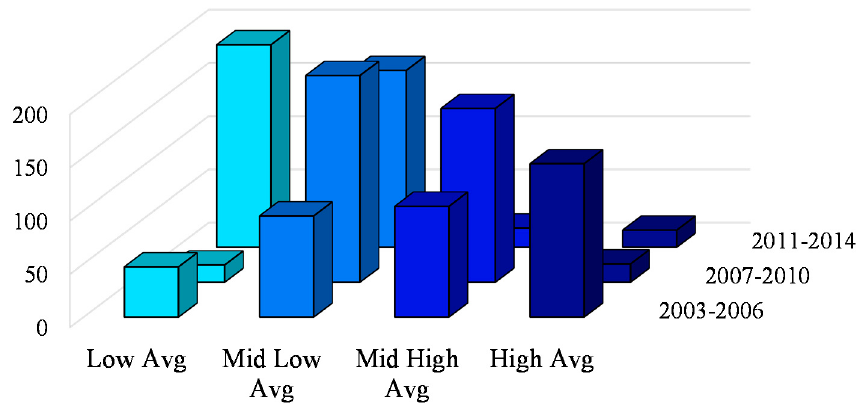
Figure 5. Distribution and categorization of normalized groundwater levels in Oklahoma in 2003–2014. Source: Authors’ calculations and visualization.